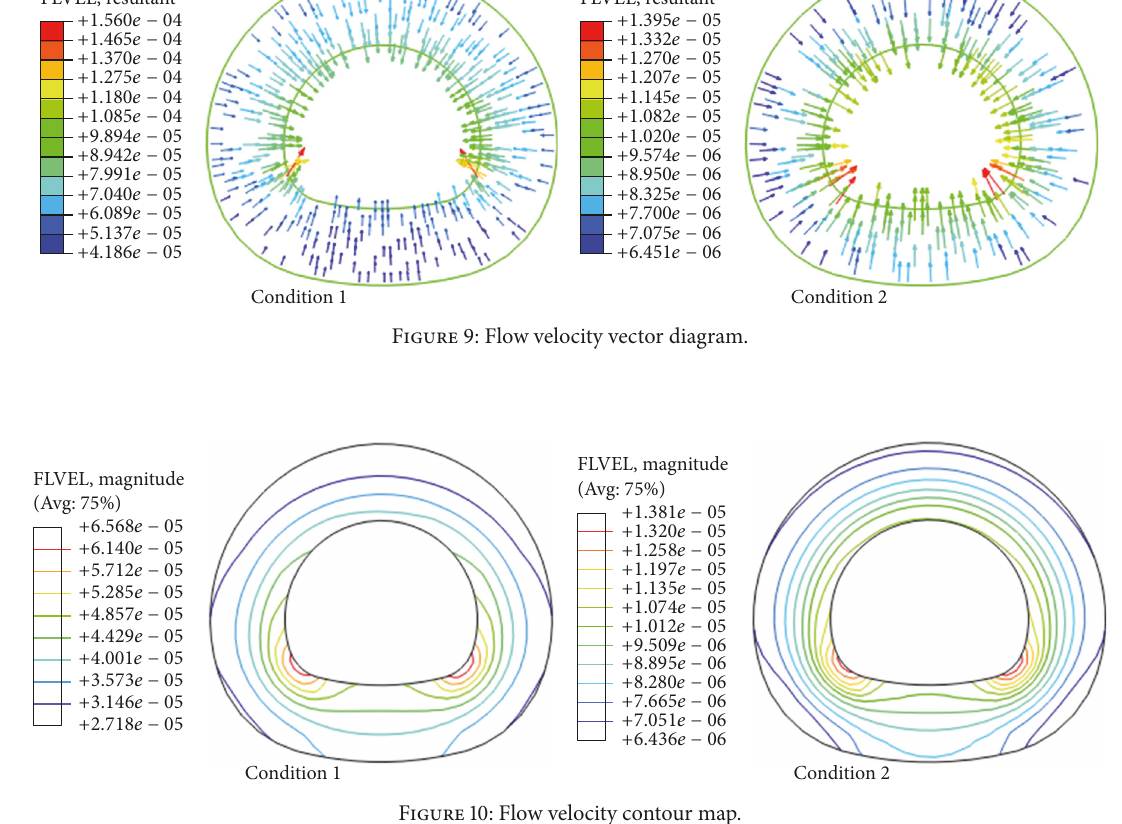
Figure 10: Flow velocity contour